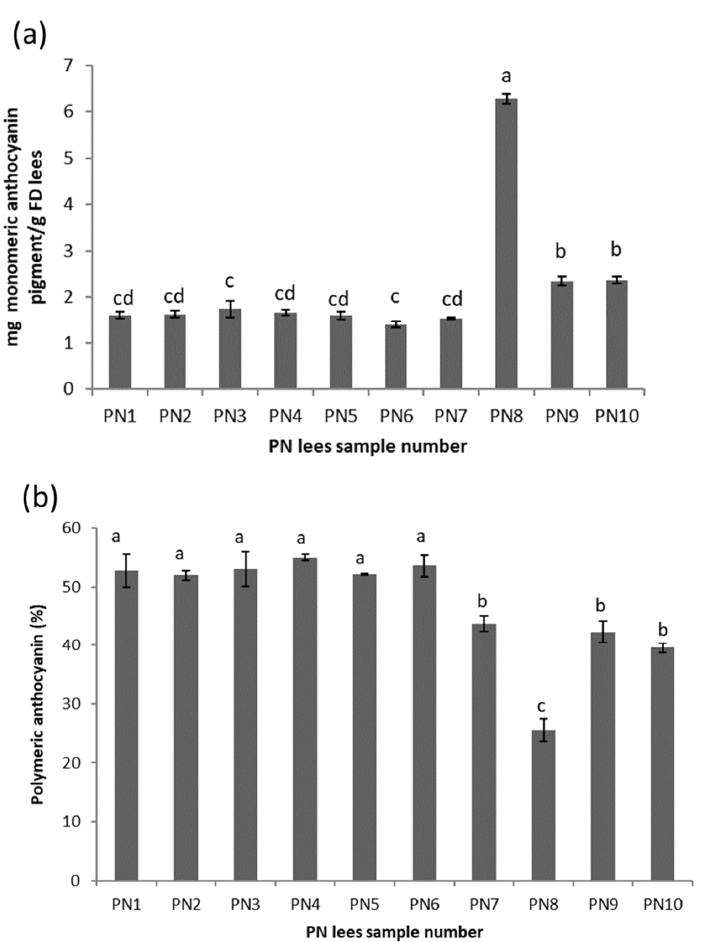
Figure 3. ( a ) Total monomeric anthocyanin pigment (mg of monomeric anthocyanin pigment/g of FD lees) of different wine lees extracts. Means that do not share the same letter (a–d) are significantly different ( p < 0.05). Error bars represent the standard deviation of replicate samples ( n = 3). ( b ) Polymeric anthocyanin pigment percentage of different wine lees extracts investigated in the present study. The percentage of the polymeric anthocyanin (pAcy%) in the ten PN lees extracts is shown in Figure 3b. The results can be divided into three groups: high (PN1 to PN6), me- dium (PN7, PN9, and PN10), and low (PN8). The pAcy% in PN1 to PN6 ranged from 52.0 ± 0.8 to 55.0 ± 0.5%. These six lees samples were obtained in July and August post malo- lactic fermentation (MLF), which was about 2 to 3 months later than when PN7 to PN10 were obtained. These results were inconsistent with the finding in a wine reported by Burns and Osborne [23], where a wine that underwent MLF showed a significantly lower polymeric pigment content than wines that had not undergone MLF. The possible expla- nation for why PN1 to PN6 showed a higher pAcy% could be the polymerized products formed from anthocyanins in the course of wine aging, often described as polymeric pig- ments, resulting from the reaction of anthocyanins with tannins [24]. It was then suspected that PN1 to PN6 underwent more polymerization during the extra 2 to 3 months before taking their lees sample.